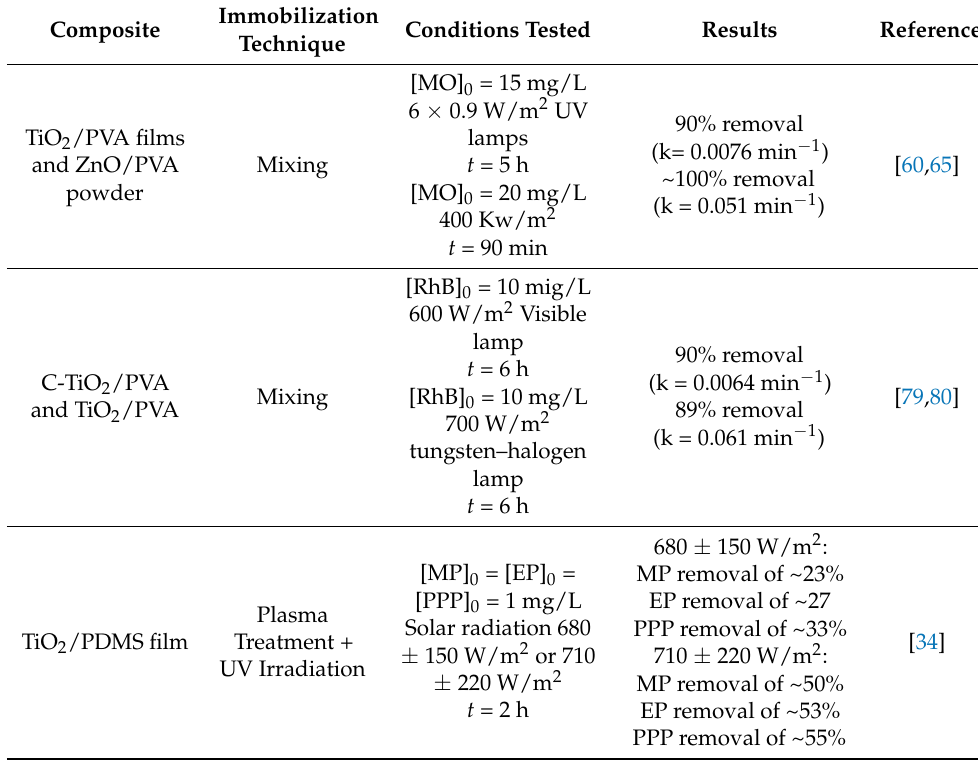
Table 8. Summary of studies that have analyzed the effect of the radiation intensity on the polymer- supported photocatalysis